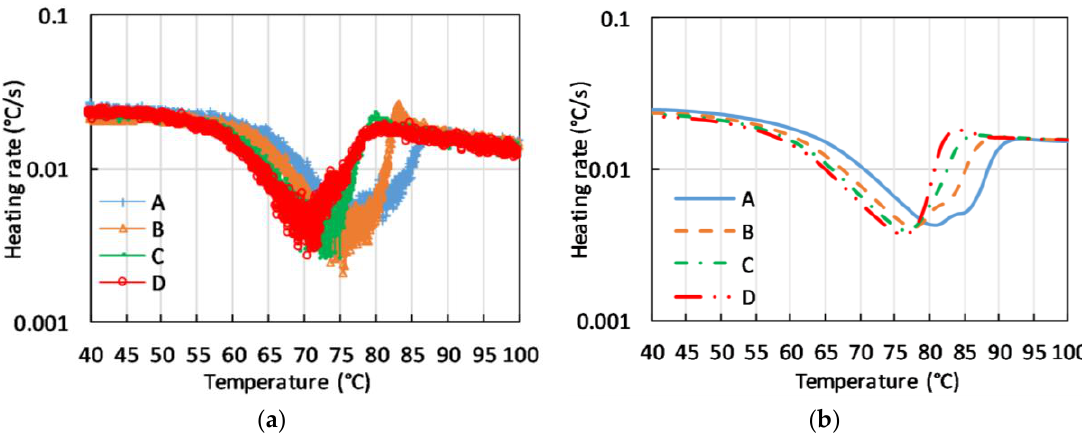
Figure 9. Experimental ( a ) and modeled ( b ) heating rate vs. temperature at points A – D, in the active phase of coarse porous C-PCM. FE model considered the porous material as a cubic rod-side lattice.